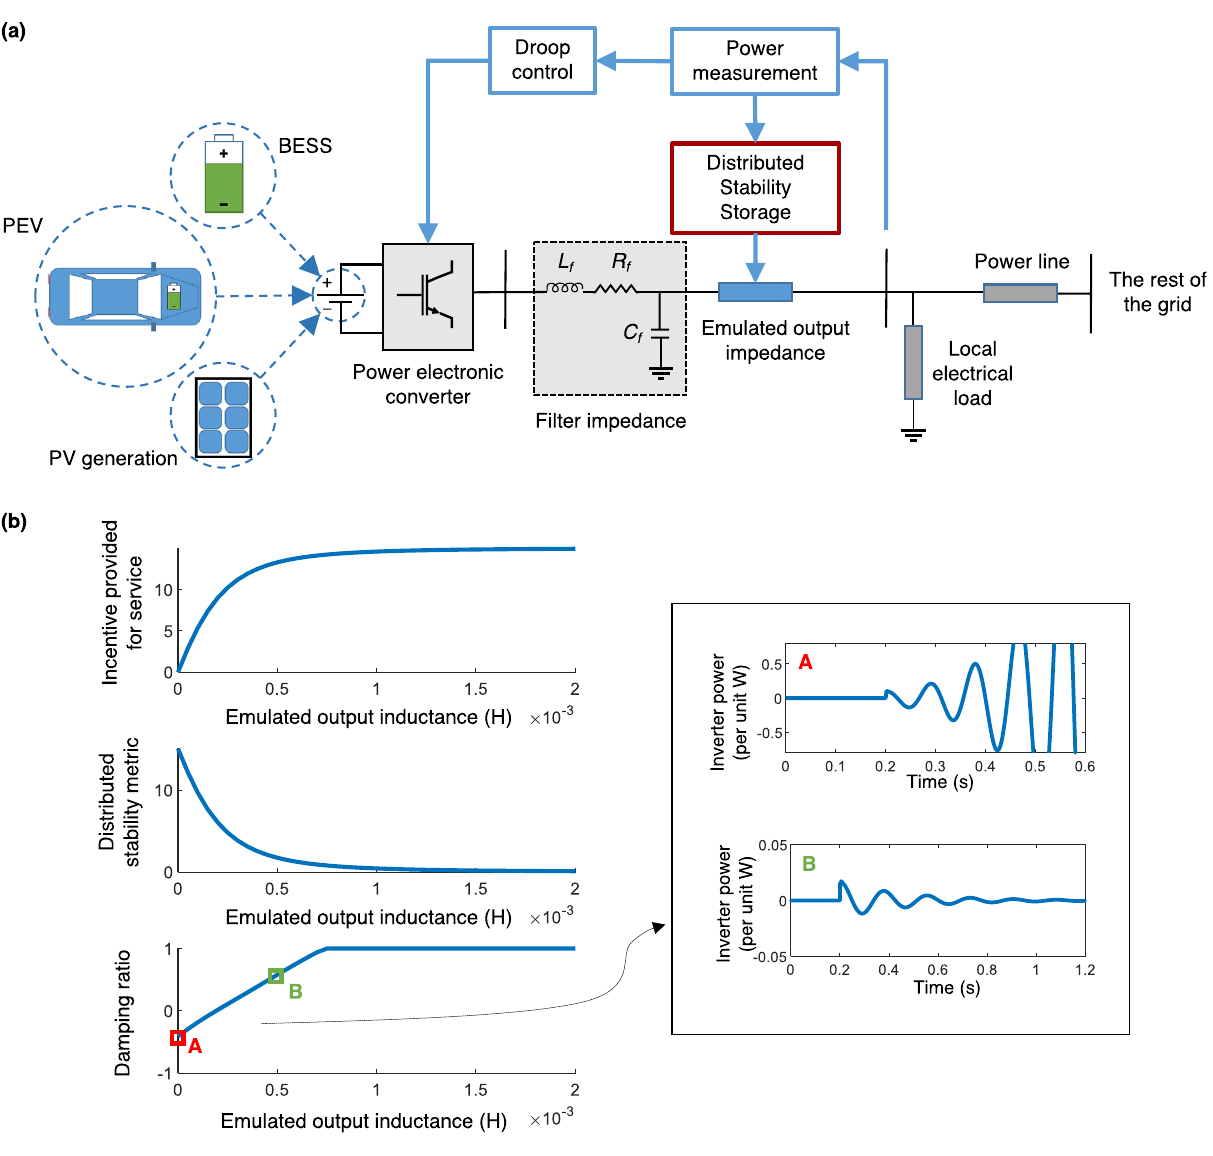
Figure 3. How VSGs can stabilize the power grid by performing as what we call stability storage . ( a ) Schematic of a VSG connected to the grid. The energy source could be a battery, electric vehicle, or renewable generation. The VSG emulates a virtual impedance to contribute stability storage to the grid. ( b ) Illustrating how the proposed distributed stability metric and damping ratio of the VSG vary as the emulated output inductance increases. The incentive for providing stability storage is simply the negative of the distributed stability metric, offset to be always positive. The insets on the right present the time responses of the system to a small load disturbance at 0.2 s. [BESS: Battery Energy Storage System, PEV: Plug-in Electric Vehicle, PV: Photovoltaic].